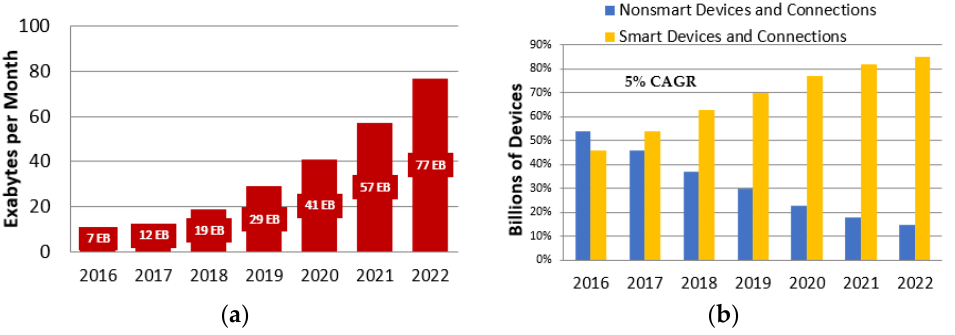
Figure 1. Cisco Annual Report from 2016 to 2022 [2]: ( a ) Cisco Visual Networking Index Global Mobile Data Traffic from 2016 to 2022; ( b ) Global Growth of Smart Mobile Devices and Connections Excluding Low-Power Wide-Area (LPWA).